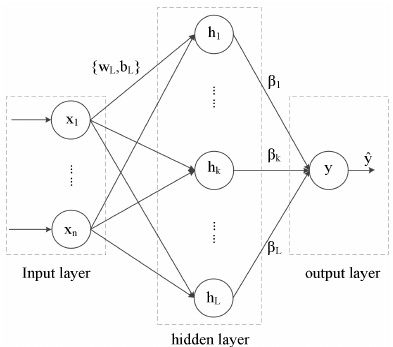
Figure 1. Random Vector Functional Link Neural Network (RVFLNN)